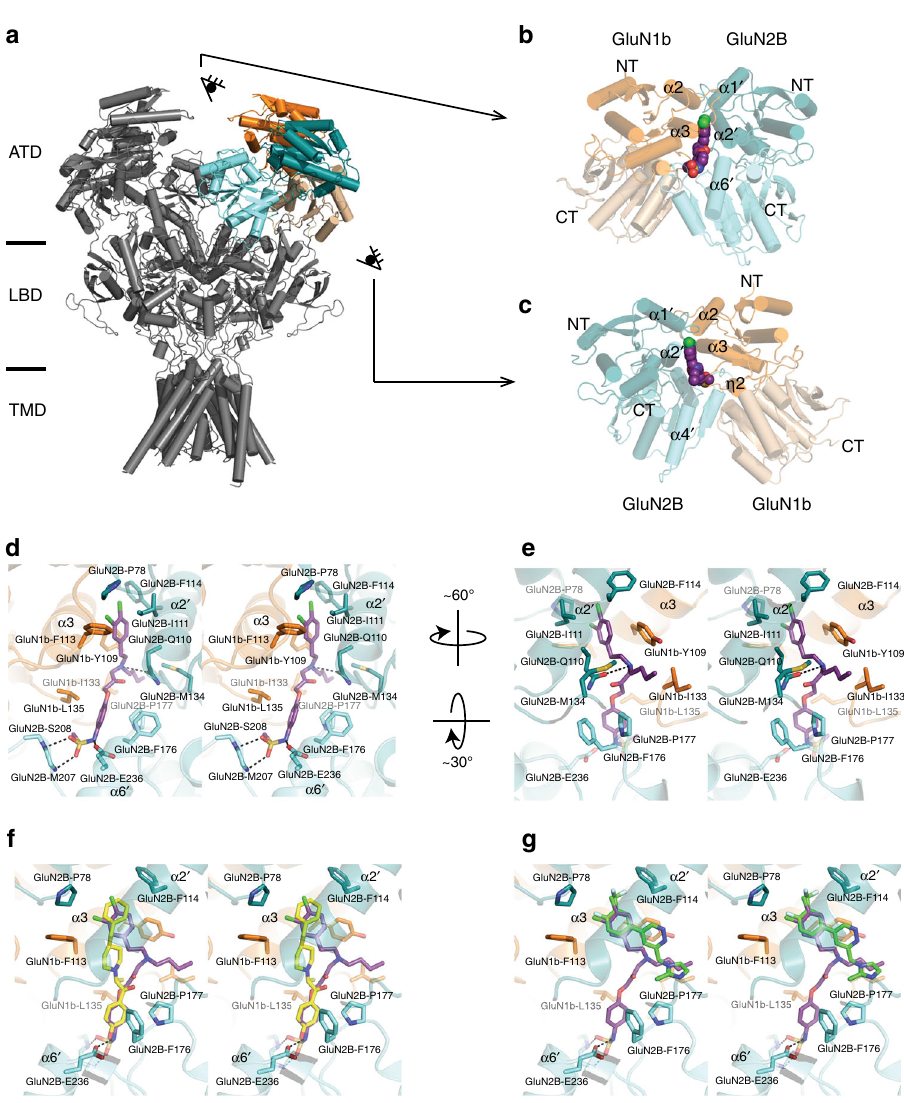
Fig. 3 Structure of the 93-series binding site. a The intact heterotetrameric GluN1b/GluN2B NMDA receptor 34 is composed of three structured domains, with the ATD furthest from the cell membrane (PDB code: 6CNA). b , c The crystal structure of the isolated GluN1b/GluN2B ATD heterodimer bound to the pH-sensitive 93-31 reveals the ligand-binding site at the heterodimer interface, as viewed from two angles. d , e The key residues surrounding the N-alkyl chain of 93-31 are primarily hydrophobic, shown here in stereo view. f Overlay of 93-31 and ifenprodil 25 (yellow, PDB code: 3QEL). g Overlay of 93-31 and EVT-101 (ref. 29 ) (green, PDB code: